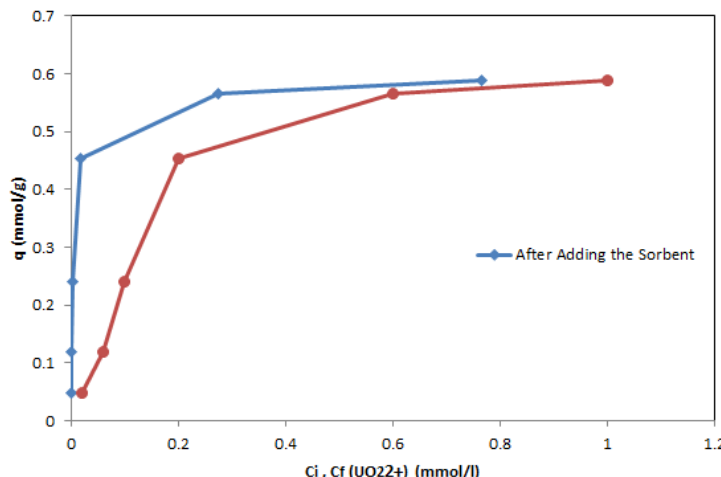
Fig. 14. Equilibrium data of uranyl ions by immobilized SC yeast adsorbent under the condition of PH = 4.5, temperature of 25 ° C, 50 mL initial volume of solution, 20 mg immobilized SC yeast adsorbent and equilibrium time of 3.5